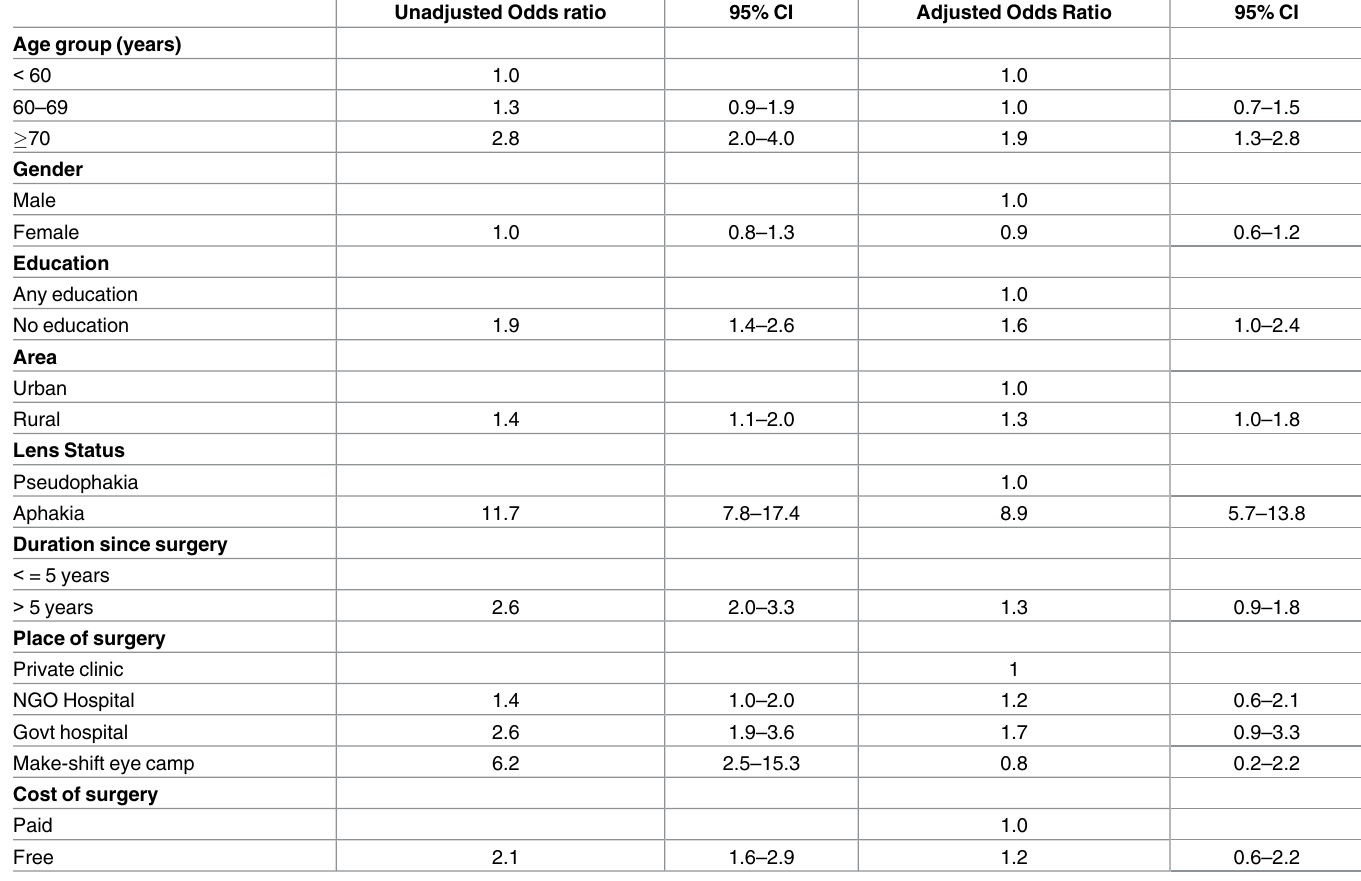
Table 5. Logistic regression analysis showing the risk factors for poor visual outcomes after cataract surgery (n = 1203 eyes). Unadjusted Odds ratio 95%